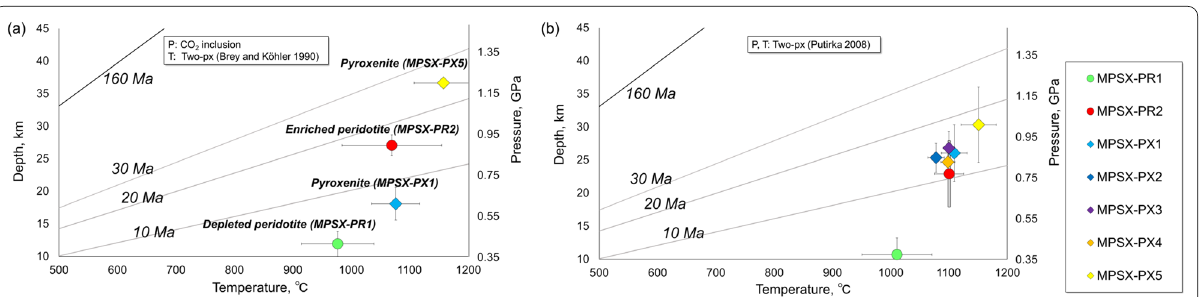
Fig. 8 Depth–temperature diagram from geothermobarometry of ultramafic xenoliths. The detailed data are provided in Table 2. Each age-equivalent geotherm is drawn using the plate model of GDH1 (Stein and Stein 1992). a Depth and temperature of xenoliths acquired by the density of CO 2 inclusions and two-pyroxene thermometer (Brey and Köhler 1990). b Depth and temperature calculated using the two-pyroxene geothermobarometer of Putirka (2008). The estimated P–T condition at which ultramafic xenoliths are hotter than the 160 Ma-geotherm of GDH1 model. Symbols are same as for Fig. 5. Error ranges for depth are within the sizes of the symbols. The pressures were converted to depths assuming the density of the seawater, oceanic crust, and mantle to be 1.023 g/cm 3 , 2.86 g/cm 3 , and 3.30 g/cm 3 , respectively (Carlson et al. 1988; Nayar et al. 2016; Weller et al. 2019), and thickness of the crust to be 6 km based on the seismic investigation near this study area (Kaneda et al. 2010). The depth of seafloor (i.e., thickness of seawater) was assumed to be 5600 m from each seafloor survey of research cruises in this study